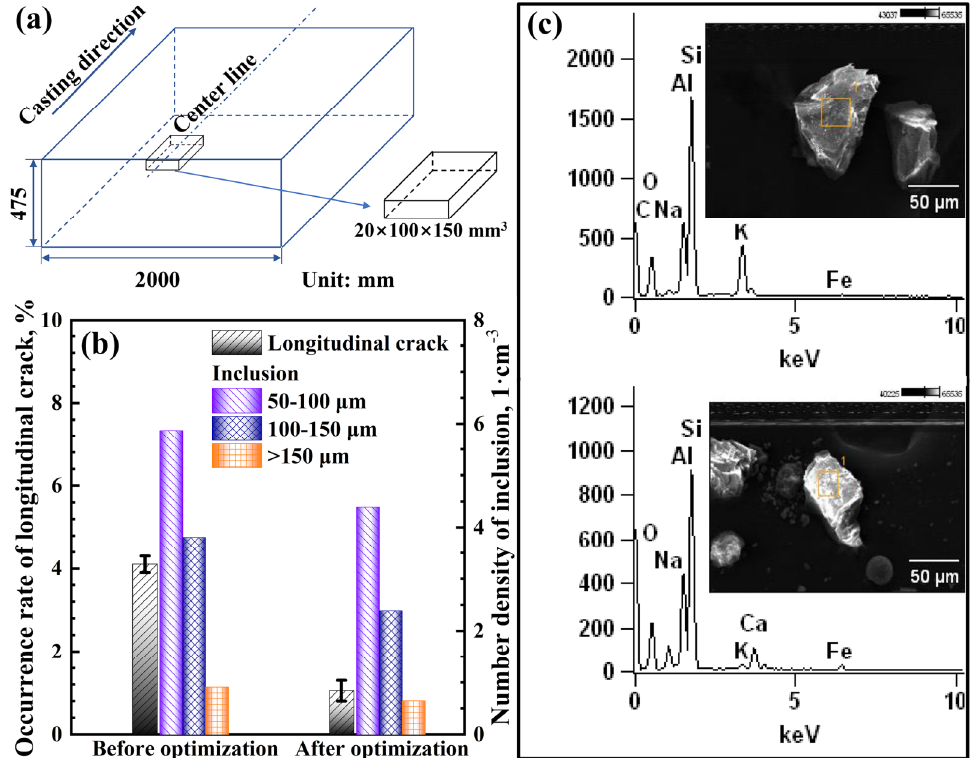
Figure 12. Schematic diagram of samples used for galvanostatic electrolysis ( a ); longitudinal crack occurrence rate and large inclusion content before and after optimization ( b ); and inclusions originated from slag entrainment in mold ( c ).